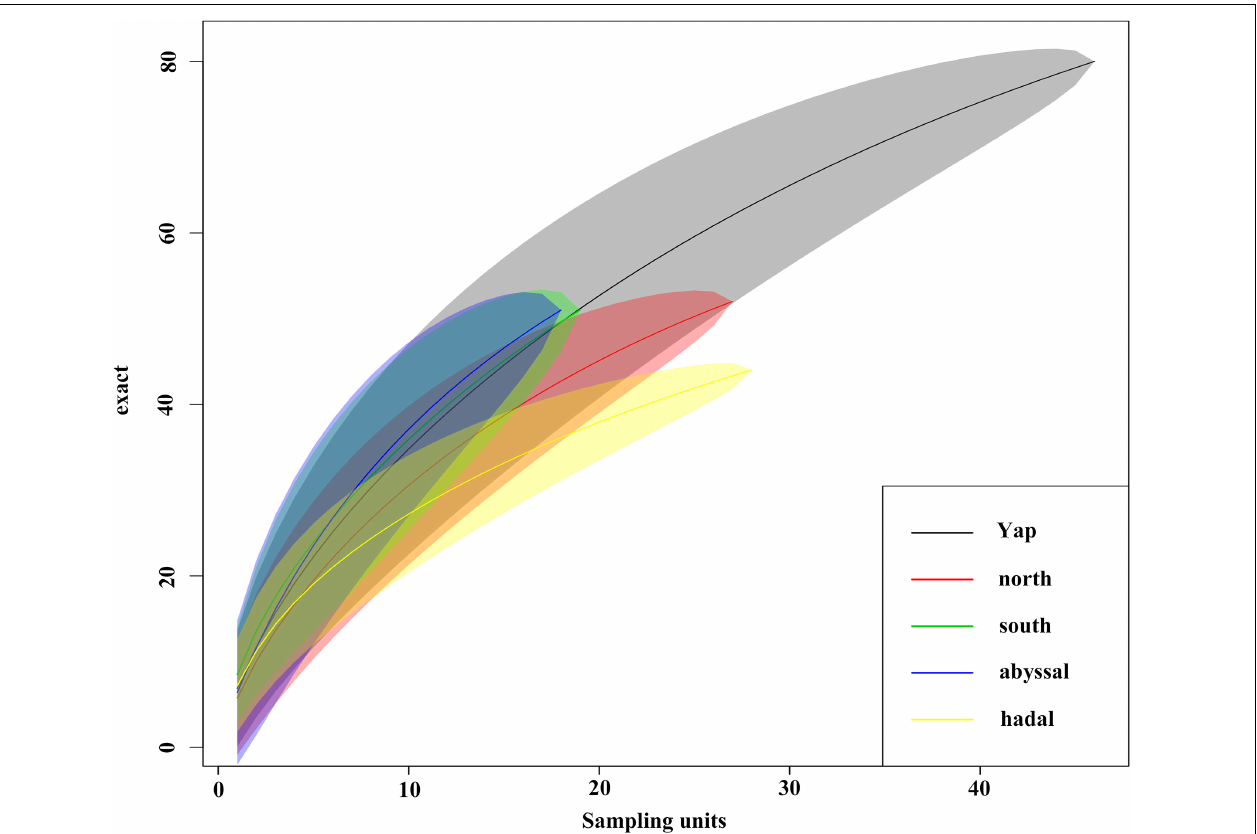
FIGURE 5 | Species accumulation curves calculated for the whole trench, the north and south sections and the abyssal and hadal zones